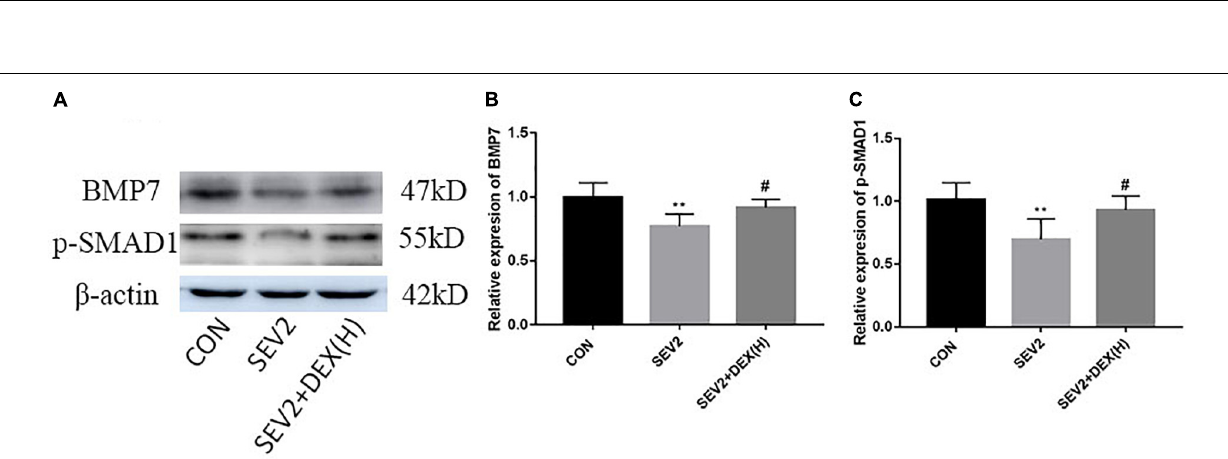
Frontiers in Neuroscience |